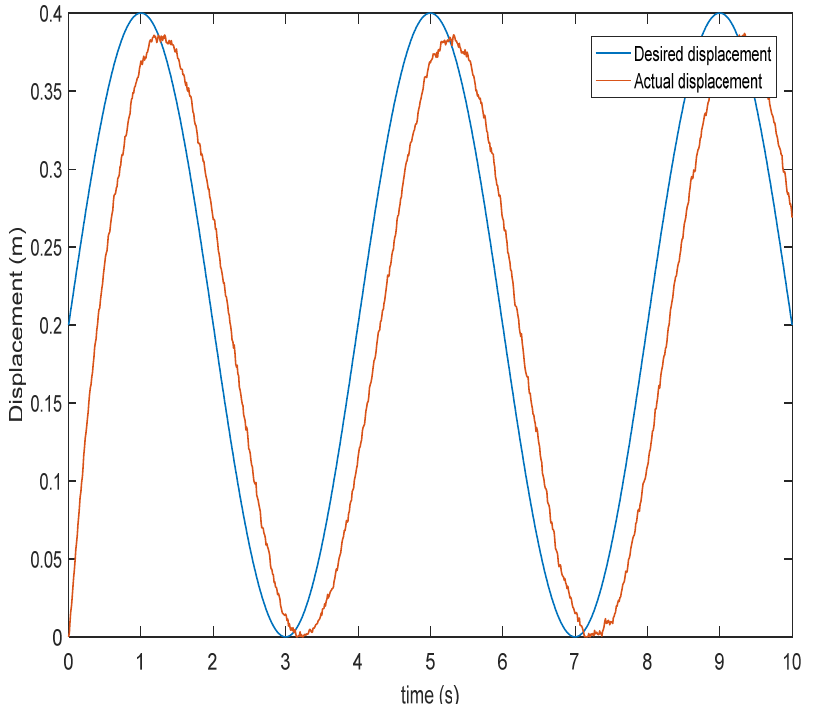
Figure 7. Displacement tracking curve of adaptive reaching law SMC algorithm after disturbed signal.